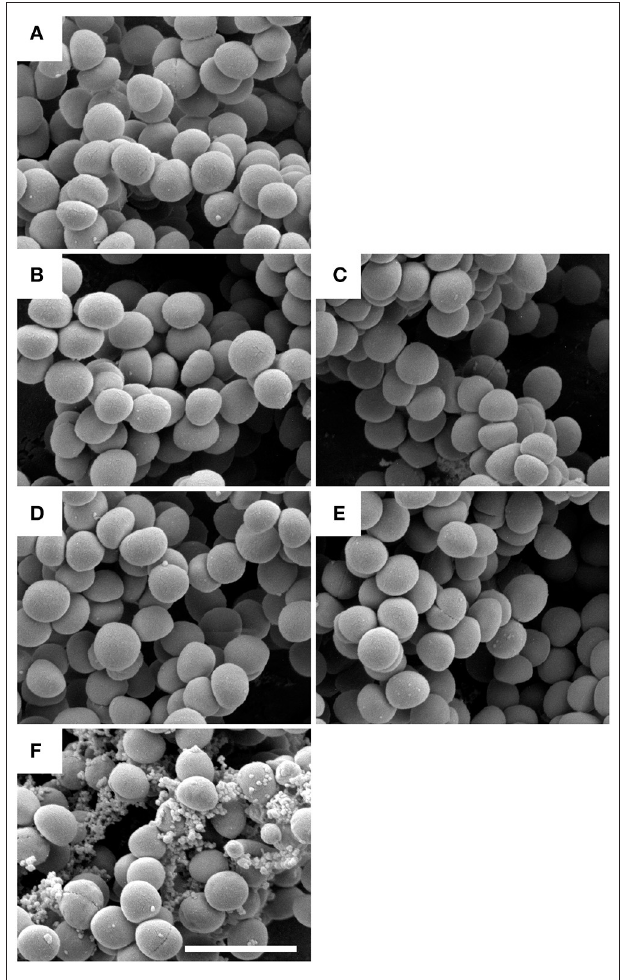
FIGURE 4 | Scanning electron microscope (SEM) analysis showed no bactericidal effect by natural crude extract (NCE) and ethanol precipitate (EP) on S. aureus Newman. S. aureus Newman bacteria were incubated with 5mg/ml NCE (B) , 40mg/ml NCE (C) , 5mg/ml EP (D) , or 40mg/ml EP (E) respectively. They were compared to control bacteria without bactericidal treatment (A) and to bacteria treated with 3mM LL-37 (F) . LL-37 induced membrane destabilization and cytoplasmic exudation, whereas the outer appearance of S. aureus bacteria appears largely undisturbed in (A–E) . The scale bar represents 2 µ